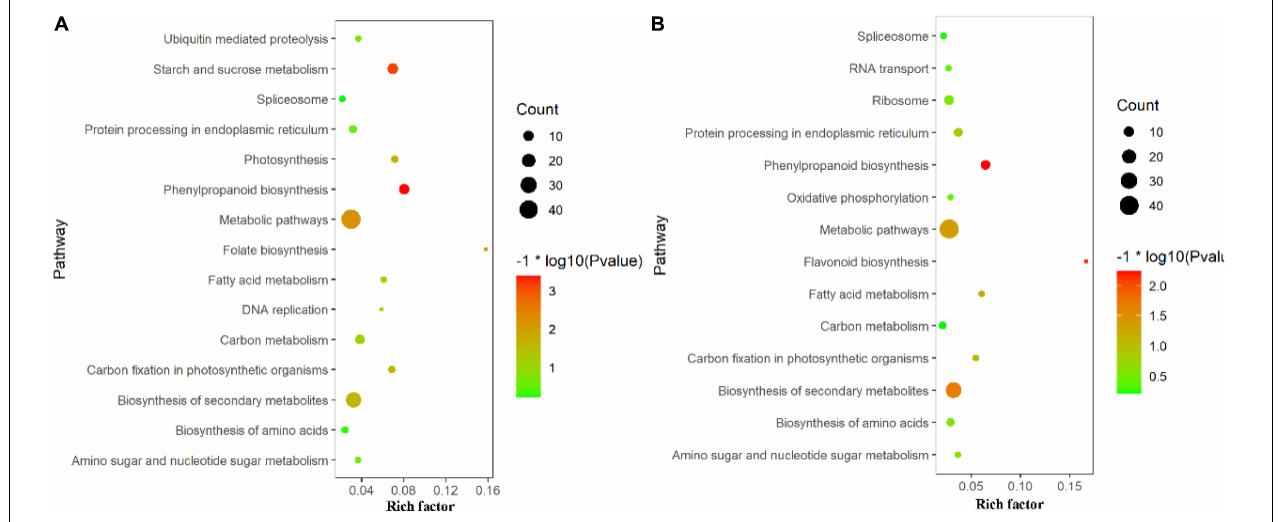
FIGURE 5 | KEGG pathway enrichment analysis of proteins with differential abundance; TOP 15 of pathway enrichment; (A) three-leaf stage; (B) tillering stage.